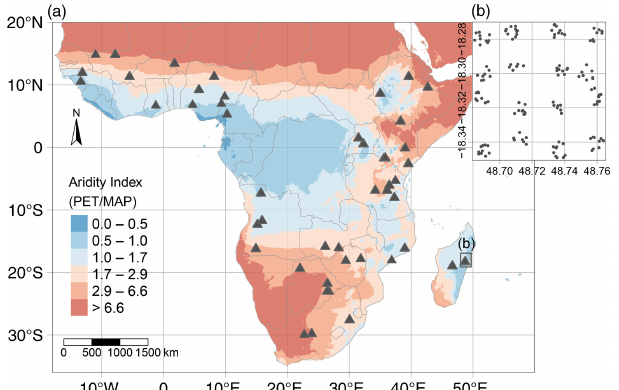
Figure 1. (a) Aridity index map and sampling scheme ( n total = 1601). Gray triangles represent individual sentinel sites where sample clusters were collected. The top-right inset (b) shows the exact sampling points within one of the sentinel sites (Didy, Madagascar) as an